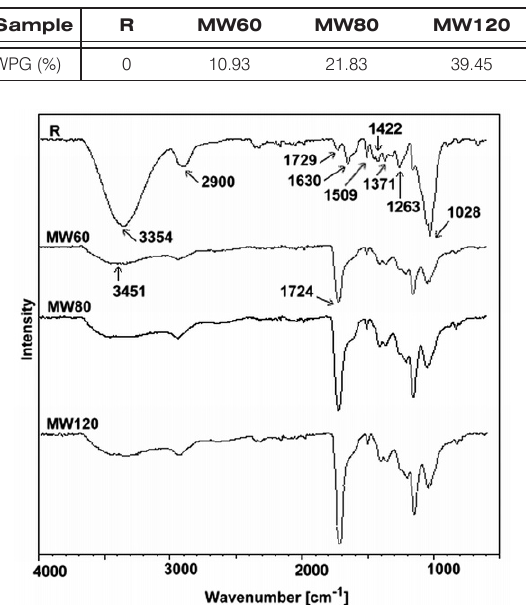
Figure 2. FTIR spectra for non-treated (R) and treated (MW)